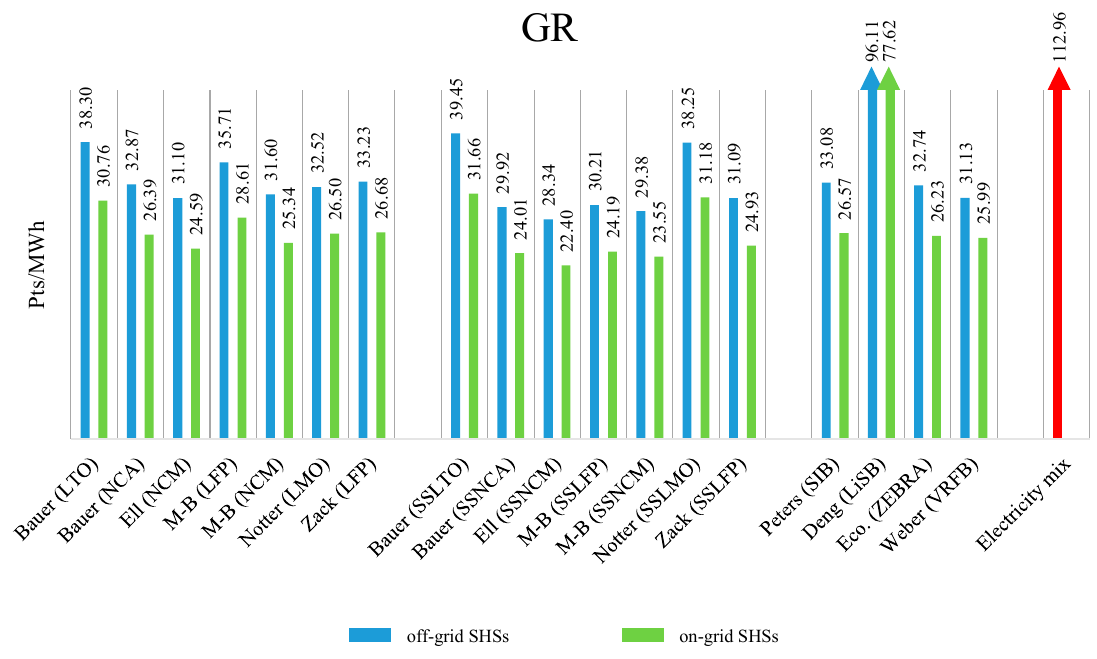
Figure 7. LCA impact values of SHSs in France as single scores.